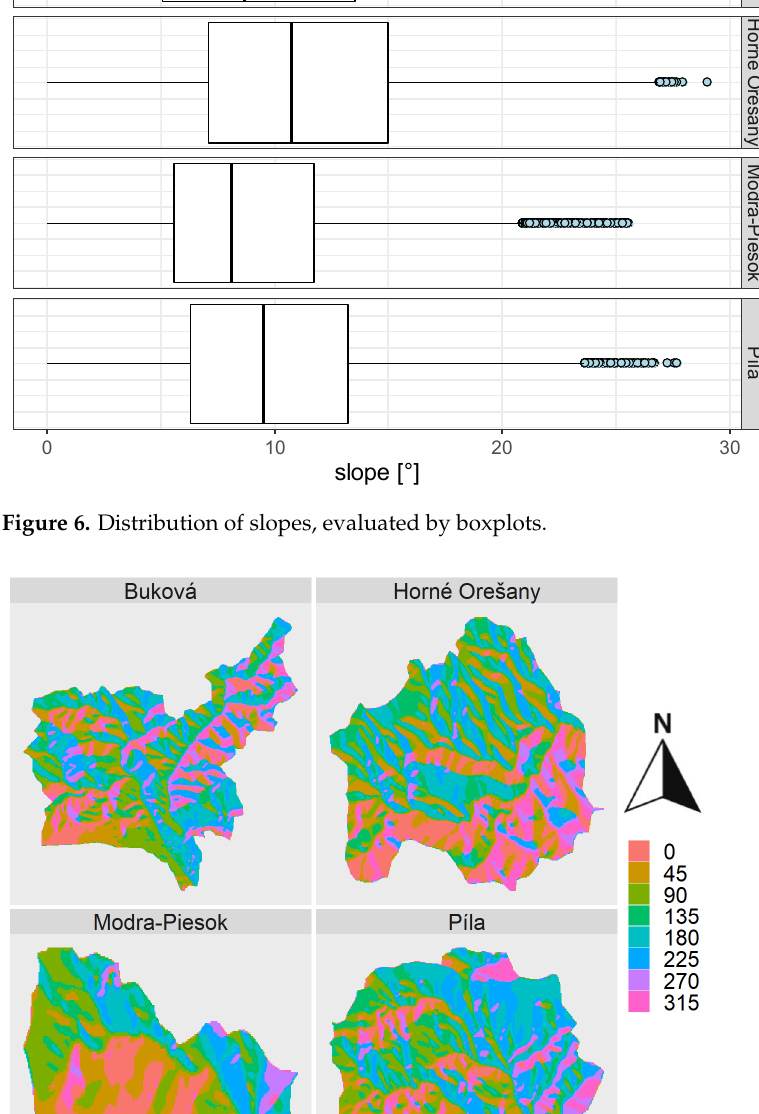
Figure 5 . The hypsometric curves of the evaluated catchments